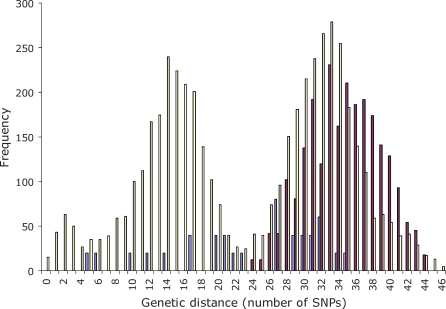
Frequency of Pairwise Genetic Distances Among 108 Strains of the MTBCPairwise comparisons of genetic distances between human-adapted strains are indicated in yellow, those between animal-adapted strains in blue, and those between human- and animal-adapted strains in red. For better illustration, the frequencies of genetic distances in the animal-to-animal strain comparisons and the animal-to-human strain comparisons were multiplied by 20 and 3, respectively. However, for the statistical analysis (see main text), the actual frequencies were used.